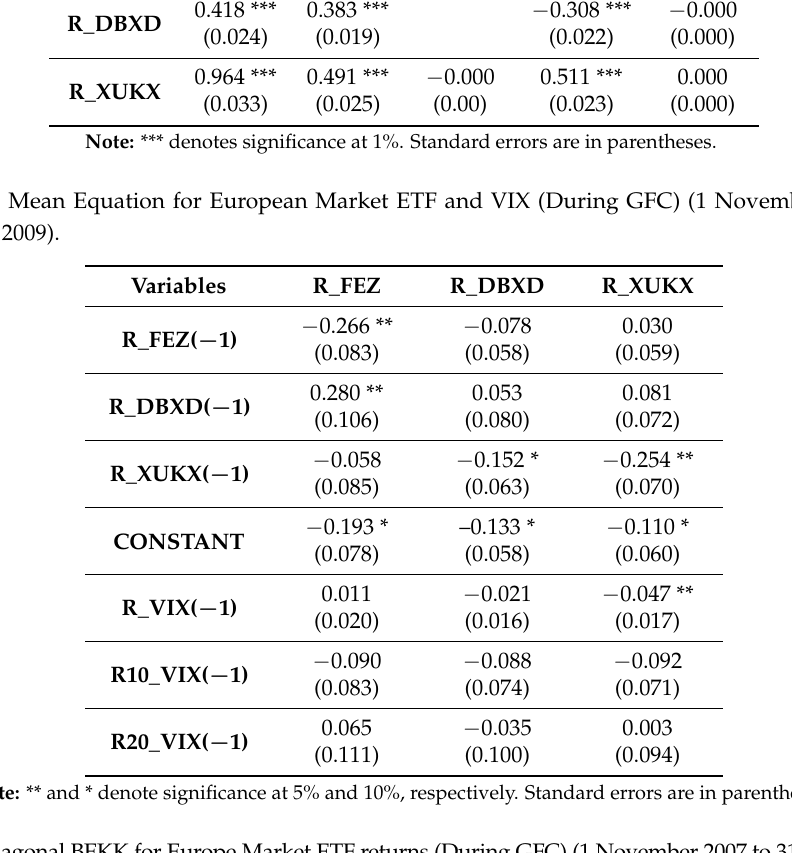
Table 13. Diagonal BEKK for Europe Market ETF returns (During GFC) (1 November 2007 to 31 March